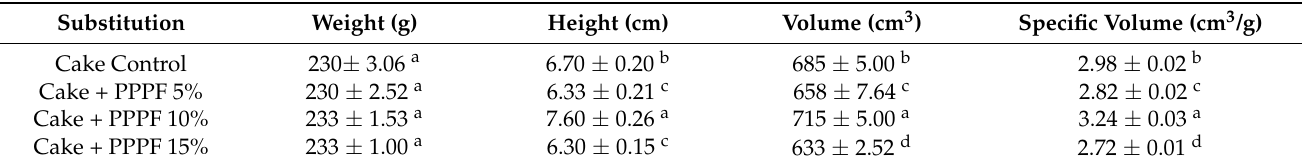
Table 7. Weight, volume, and specific volume of cakes prepared by replacing flour with various levels of PPPF.